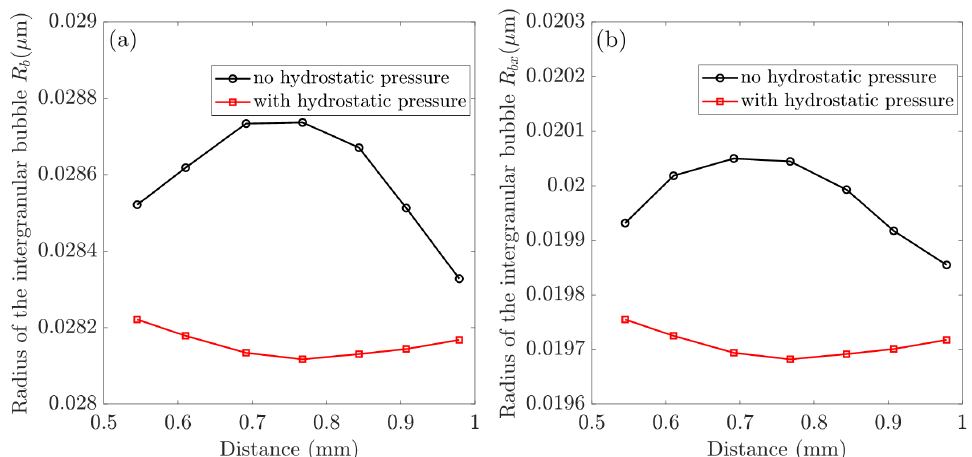
Figure 6. Hydrostatic pressure influences: ( a ) calculated the intergranular bubble radius in the non-recrystallized region as R b and ( b ) intergranular bubble radius of R bx in recrystallized